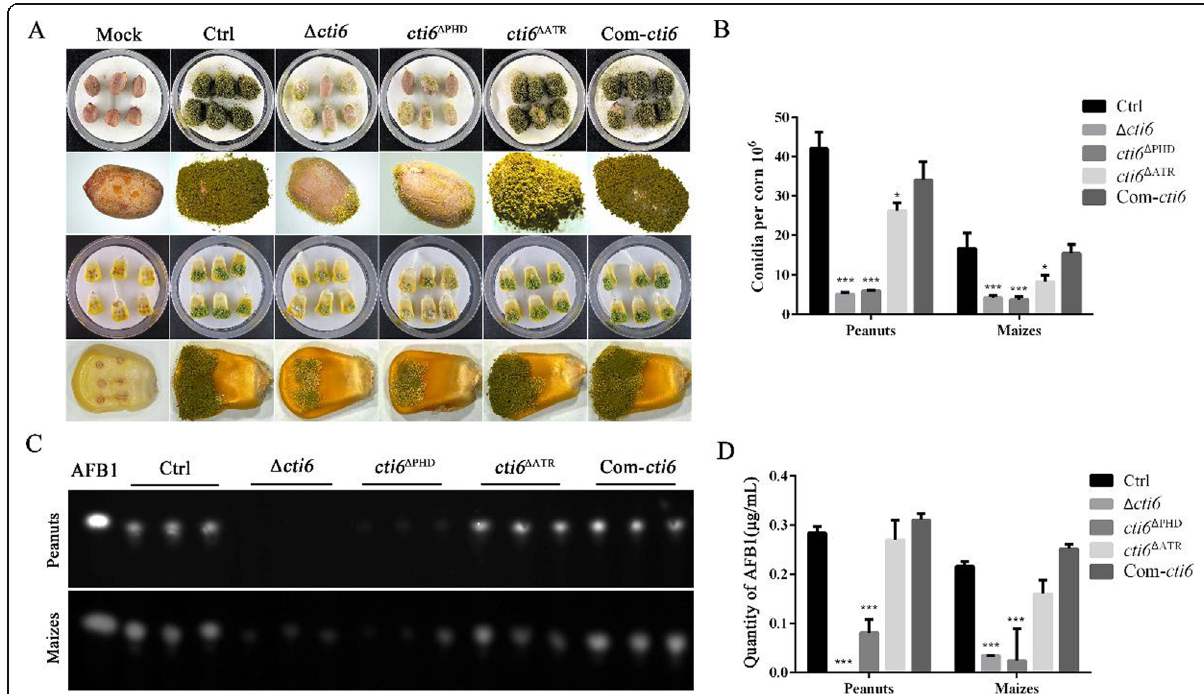
Fig. 5 The role of Cti6 in the colonization of A. flavus on peanut and maize grains. a Colonization of these A. flavus strains on peanut and maize grains. b Cti6 and its PHD domain involved in the conidiation of A. flavus . c The AFB1 production capacity of these fungal strains was analyzed with TLC analysis. d Cti6 and its PHD domain positively regulated AFB1 production in A. flavus